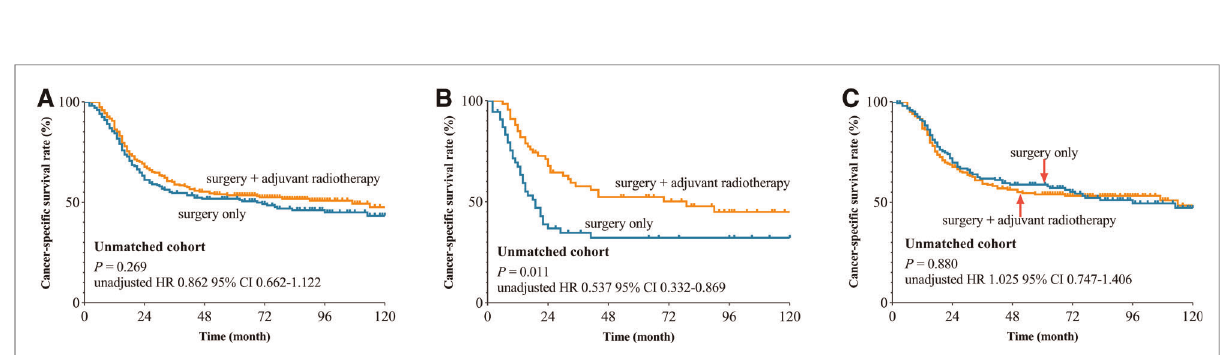
FIGURE 3 Cancer-speci fi c survival curve for oral cavity squamous cancer patients with stage T1-2N1M0 according to the treatment approaches in the unmatched cohort of Surveillance Epidemiology and End Results database. ( A ) Whole cohort, ( B ) patients with lymph nodes examined ≤ 16, and ( C ) patients with lymph nodes examined